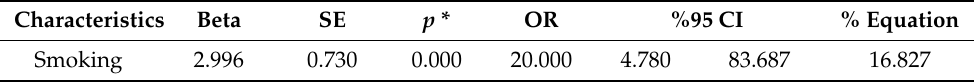
Table 5. Logistic Regression Analysis of Biochemical and Clinical